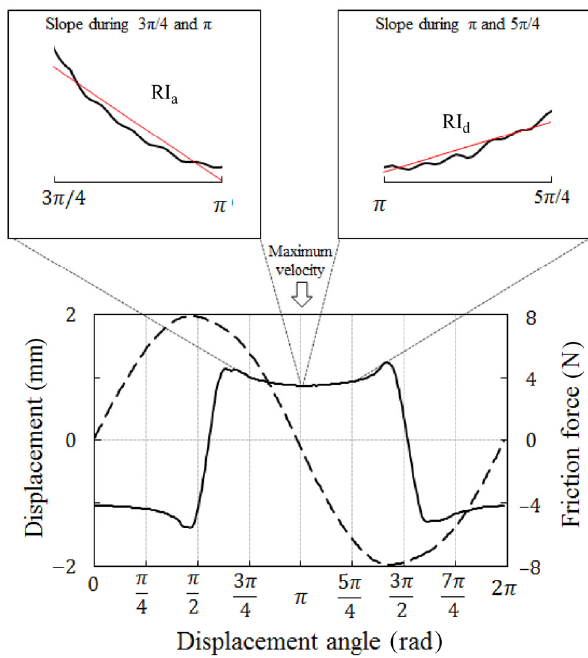
Fig. 5 Calculation concept of the roundness index (RI).